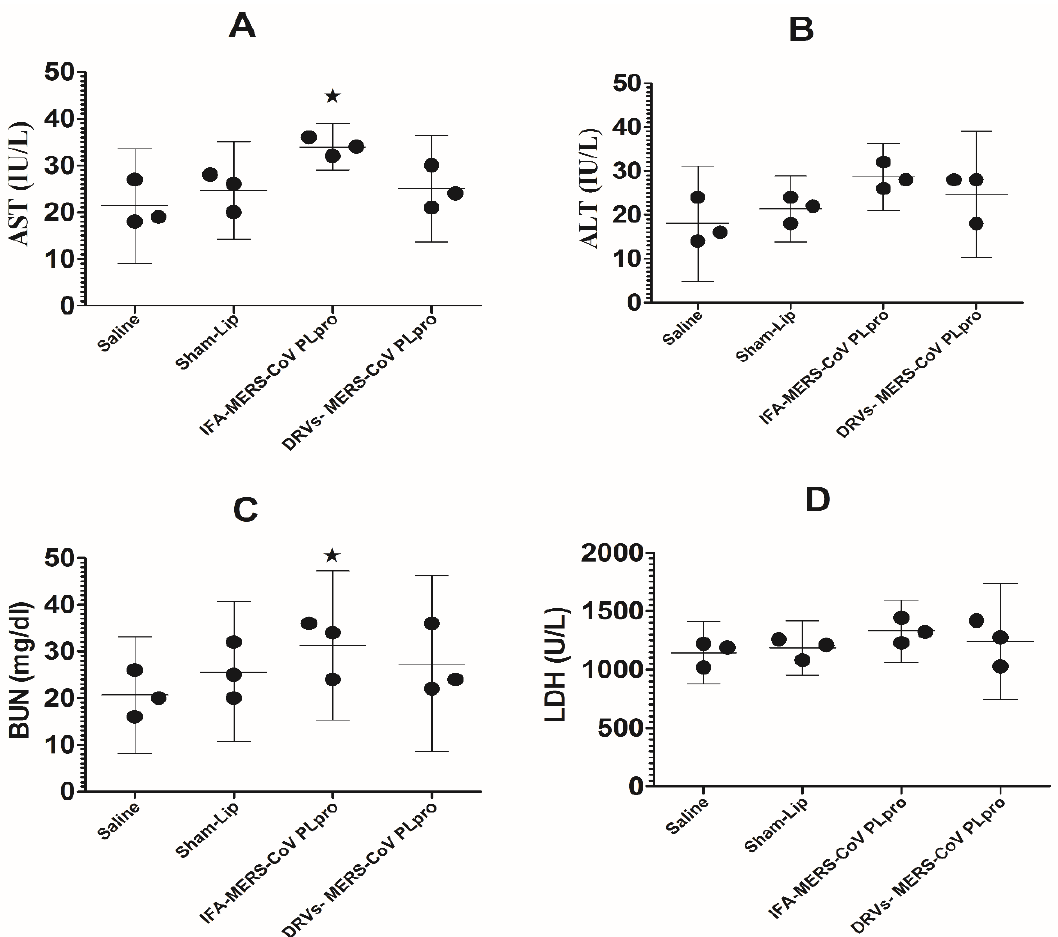
Figure 2. Safety assessment of vaccine formulations. ( A ) AST level in the control and immunized mice. Saline vs. IFA-MERS-CoV PLpro, * ( p < 0.05). ( B ) ALT level in the control and immunized mice. ( C ) BUN level in the control and immunized mice. Saline vs. IFA-MERS-CoV PLpro, * ( p < 0.05). ( D ) LDH level in the control and immunized mice. The data are represented as the mean ± SD of three independent values.